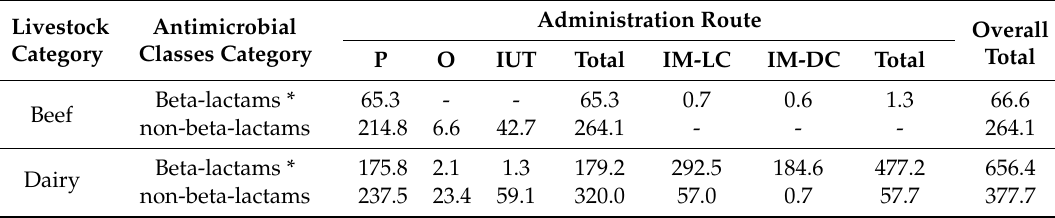
Table 5. Average yearly consumption of beta-lactams (DCD vet / year × 10 − 3 ) per individual administration route on beef and dairy farms (P = parenteral, O = oral, IUT = intrauterine, IM-LC = intramammary lactating cow, IM-DC = intramammary dry